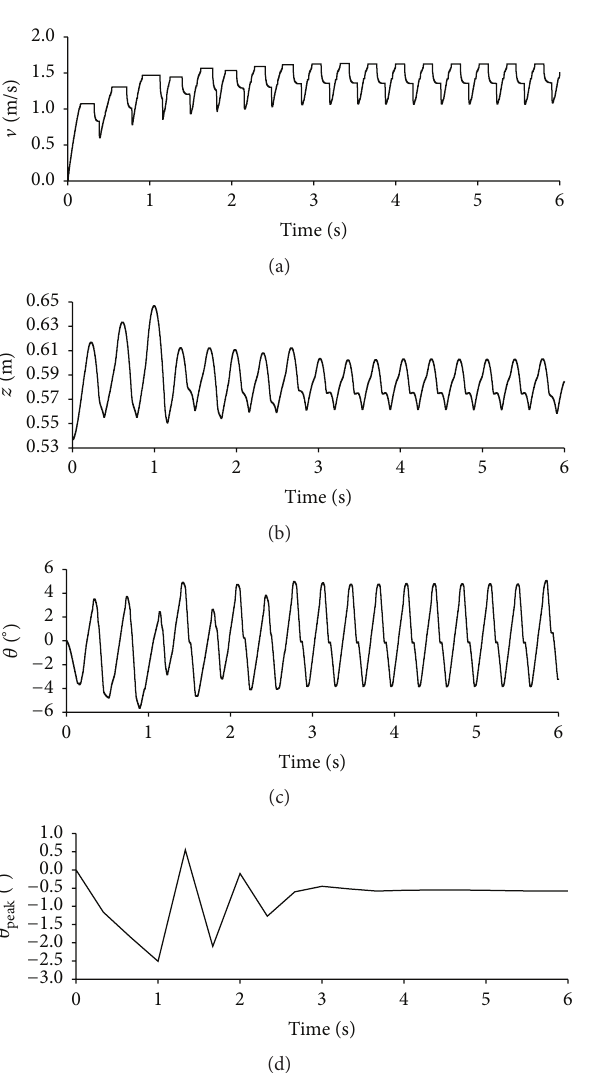
Figure 5: Kinematic variables of the cheetah bounding.